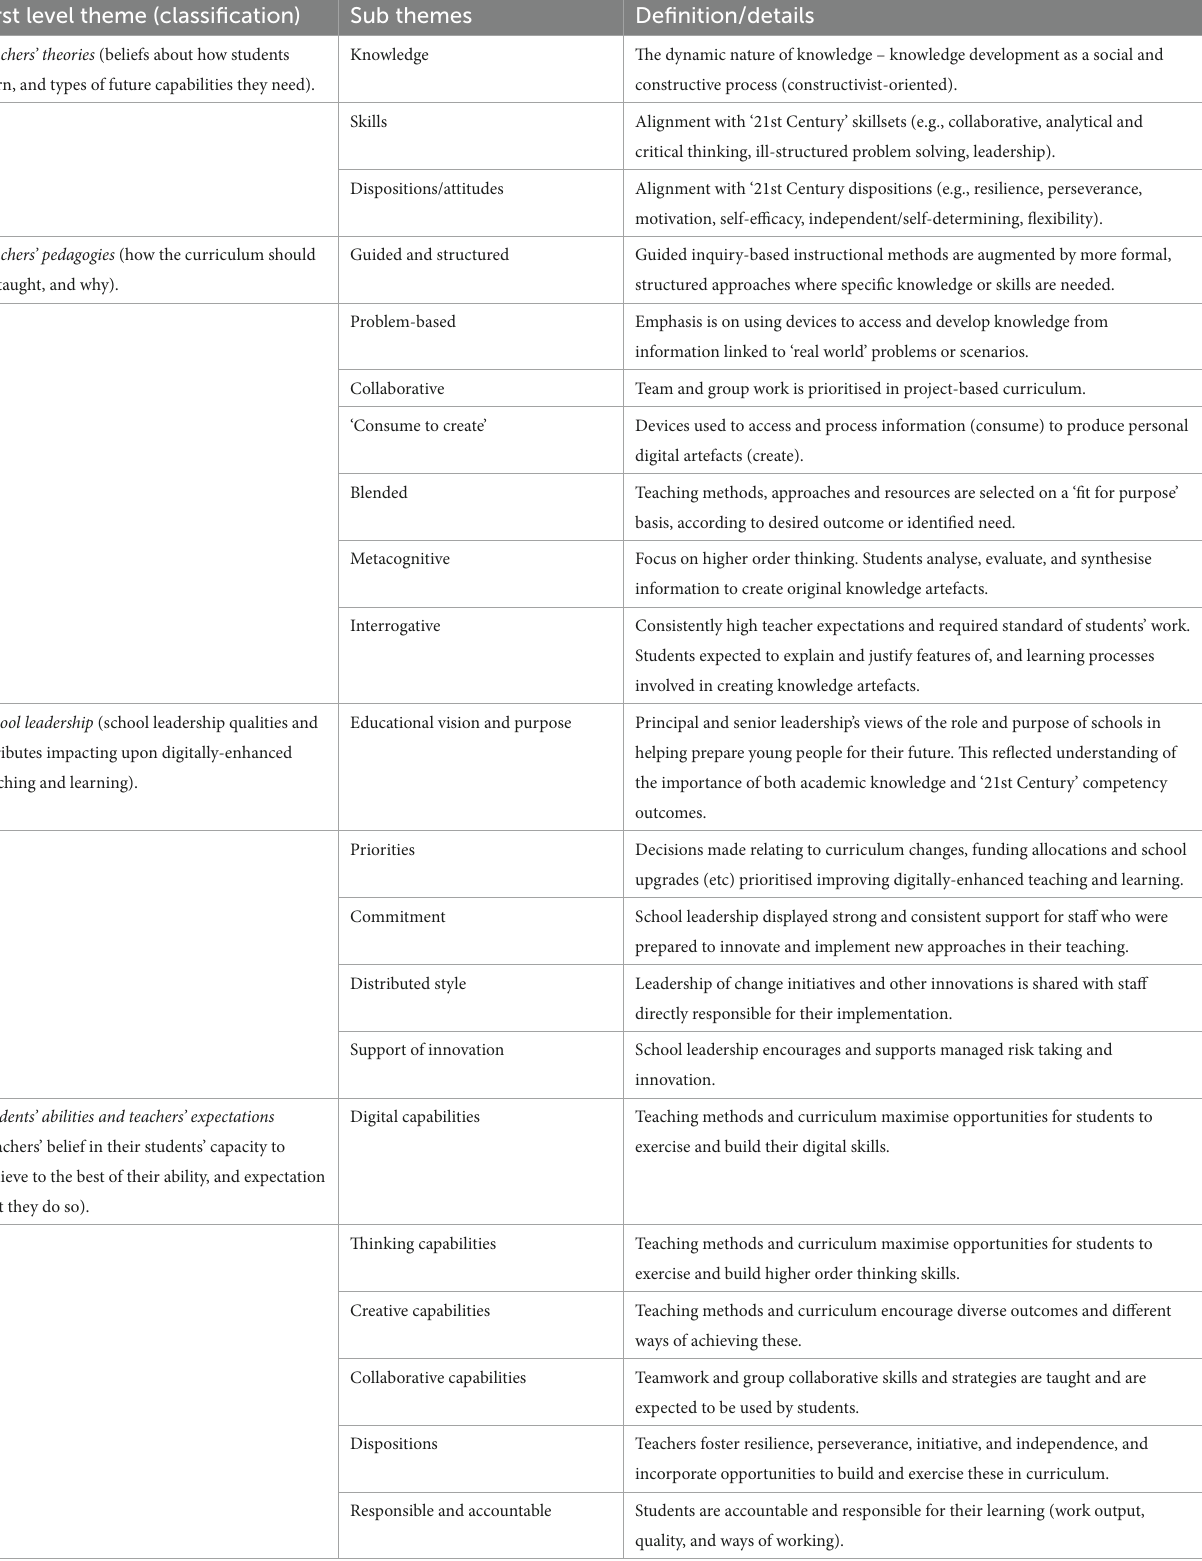
TABLE 1 First level themes, subcodes and definitions/descriptions. First level theme